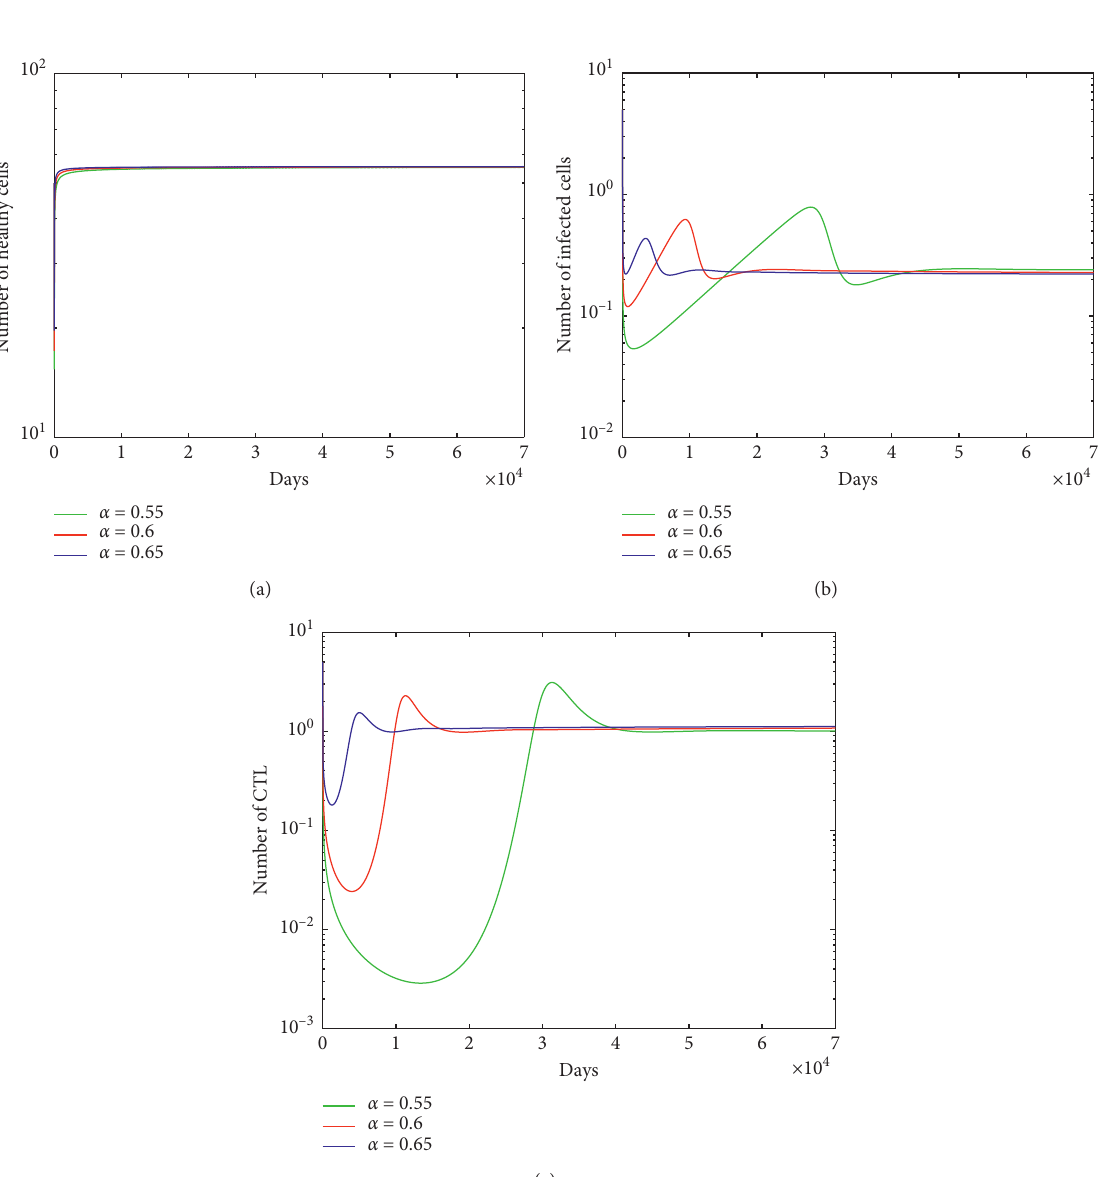
with different α 2